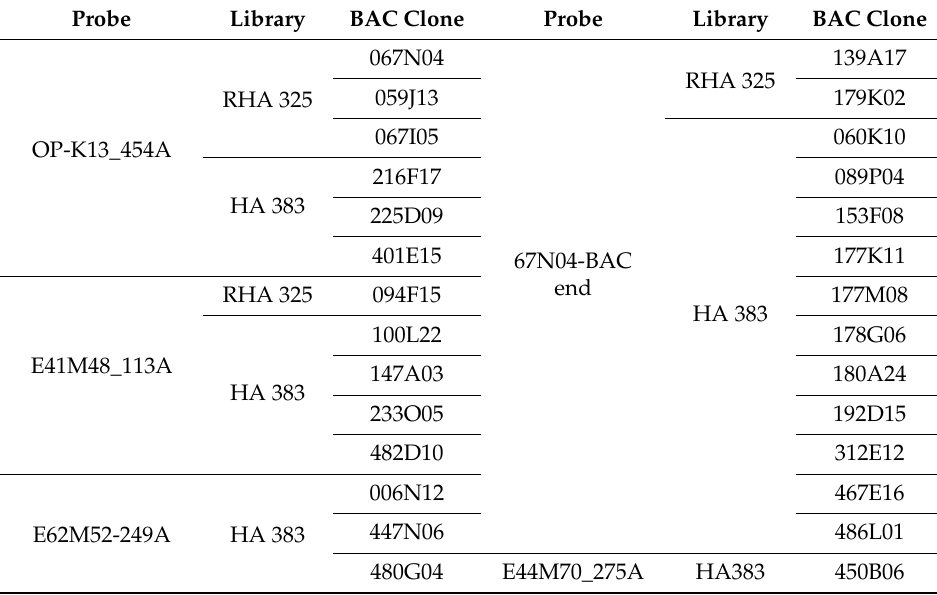
Table 1. BAC clones identified by hybridizations against BAC libraries from RHA 325 and HA